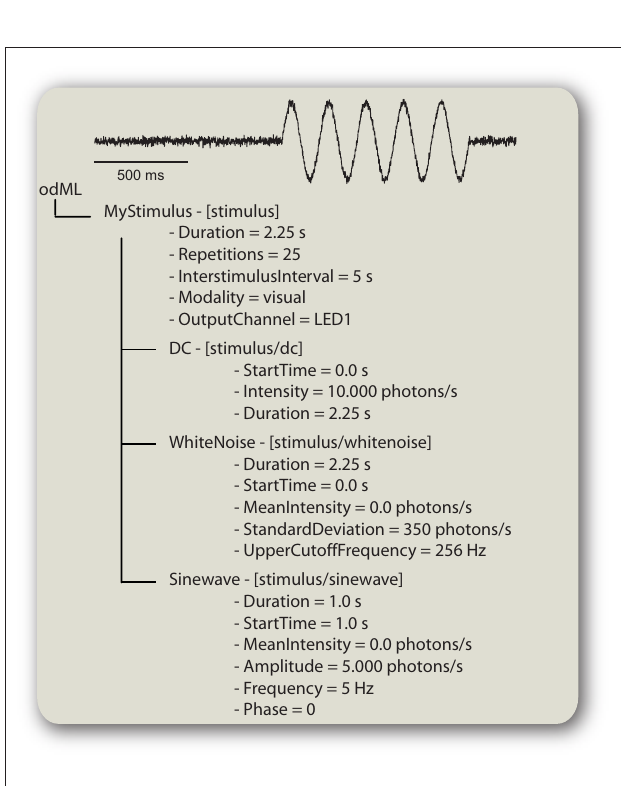
Figure 4 | Describing a stimulus in od ML. od ML description of a visual stimulus which is an additive combination of three components. The trace on top shows how the actual stimulus might have looked like. Sections are shown in the form “name – [type].”